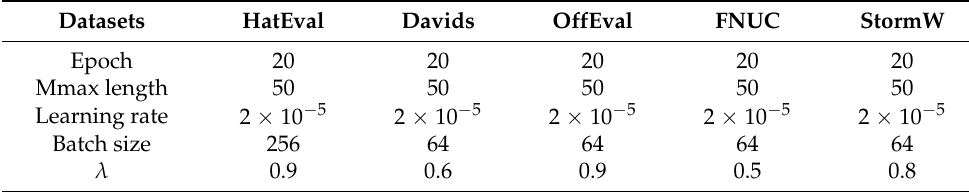
Table 2. Parameter settings on different